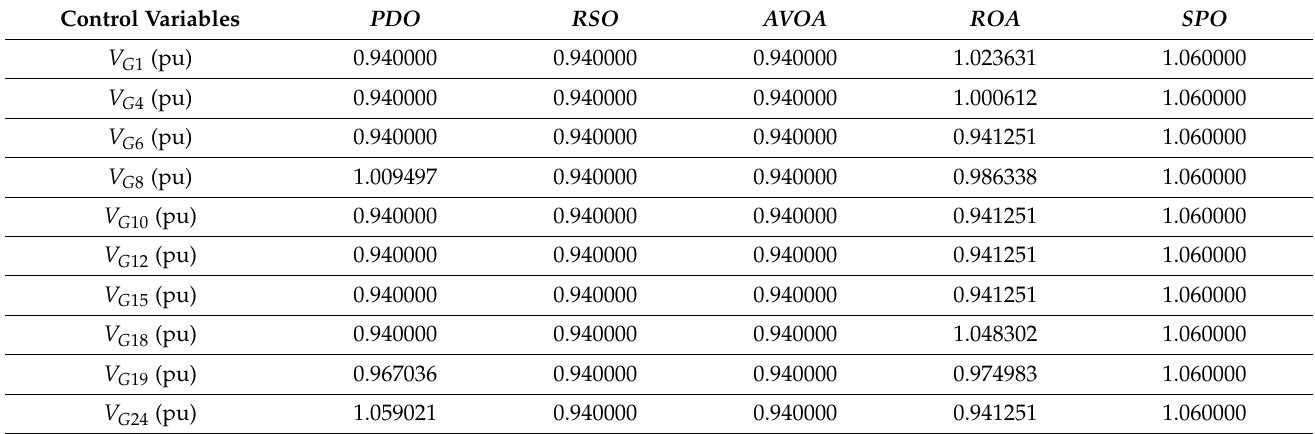
Figure 21. The AVOA voltage profile with the other compared methods for case 9. Table 23. Minimization of multi-objective functions (voltage-level deviation, operational cost, and transmission power loss) with continuous control variable settings in IEEE-118 bus.